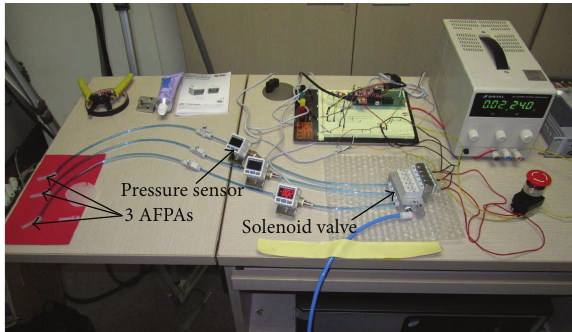
Figure 11: Experimental setup showing various